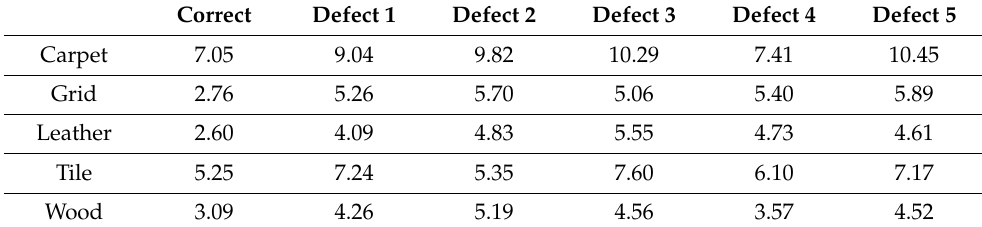
Table 8. Mean reconstruction error for all textures and their respective